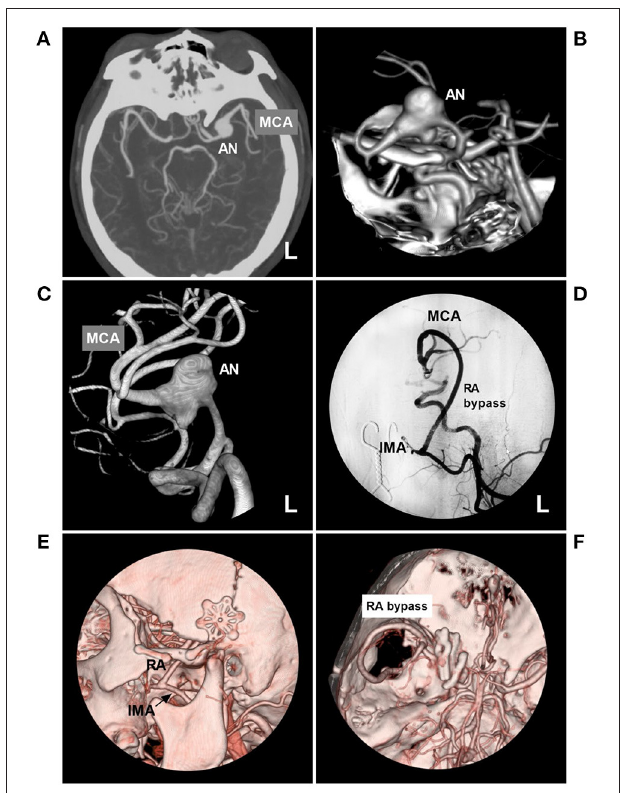
FIGURE 6 | PAO with the assistance of high-flow bypass in a circumferential AN of the MCA trunk. (A,B) Maximum-intensity projection (A) and three-dimensional reconstruction (B) of CTA showed a left circumferential AN of the MCA trunk (AN). (C) Three-dimensional DSA of the left ICA clearly showed the AN. (D) Left DSA showed that high-flow bypass was performed between the IMA and MCA beyond the AN with the RA graft. (E,F) Follow-up CTA showed the bypass. (C) the RA was anastomosed to the IMA trunk (arrow). (F) the RA was anastomosed to the MCA, and the AN was trapped by multiple clips. AN, aneurysm; CTA, computed tomography angiography; DSA, digital subtraction angiography; MCA, middle cerebral artery; ICA, internal carotid artery; IMA, internal maxillary artery; L, left; RA, radial artery; PAO, parent artery